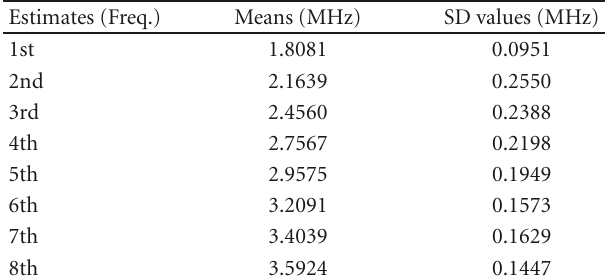
Table 4: Spread of MAP estimates of number of frequency for the measured MB response.